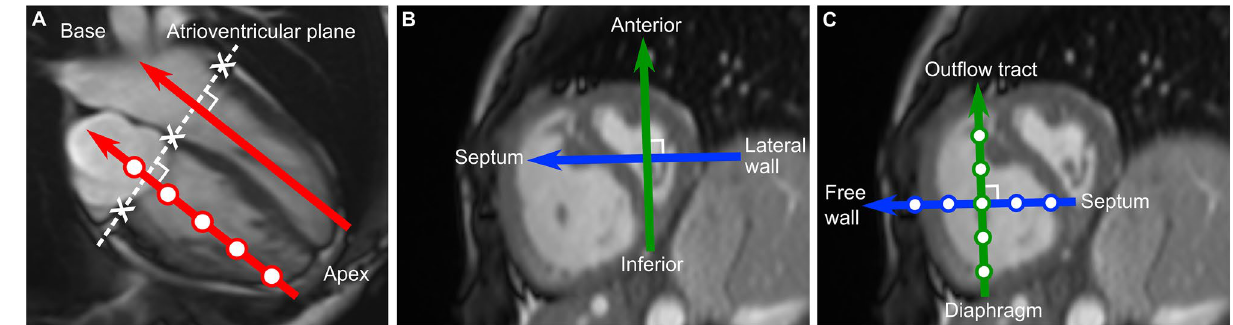
Figure 2. Definition of the intraventricular three-dimensional directions, using an orientation system previously described 7 . ( A ) Semi-automatic definition of the atrioventricular (AV) plane in end diastole by manually marking the AV junction points (white crosses) in the long-axis views, and thereafter an automatic construction of a two-dimensional plane fitted to the points. The apex-base direction is defined as perpendicular to the AV-plane. ( B ) and ( C ) The lateral wall-septum direction is perpendicular to the apex-base axis, and aligned with the left ventricular outflow tract in the 3-chamber long-axis image. The inferior-anterior direction is perpendicular to both the apex-base and lateral wall-septum directions. The transverse directions were defined from the left ventricle ( B ) and translated to the right ventricle ( C ), resulting in parallel interventricular